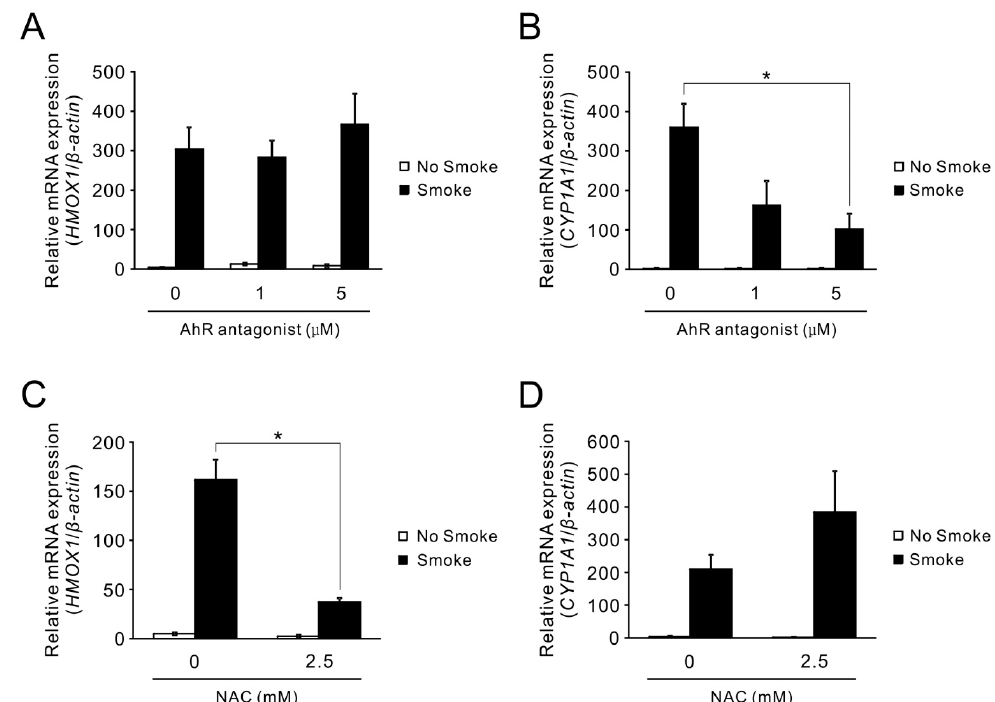
Figure 2. Differential mechanisms of cigarette smoke-induced HO-1 and CYP1A1 gene expression. ( A , B ) HBE1 cells were pre-treated with 1 or 5 µ M AhR antagonist followed by cigarette smoke at 180 mL for 20 min and analyzed for HO-1 ( A ) and CYP1A1 ( B ) mRNA level by real-time quantitative reverse transcriptase polymerase chain reaction (qRT-PCR) at 24 h. * p <0.05 ( n = 3; mean ± S.E.M.); ( C , D ) HBE1 cells were pre-treated with 2.5 mM N -acetylcysteine (NAC) and then exposed to smoke treatment for 24 h. The mRNA levels of HO-1 ( C ) and CYP1A1 ( D ) were assessed by qRT-PCR. * p < 0.05 ( n = 3; mean ± S.E.M.).